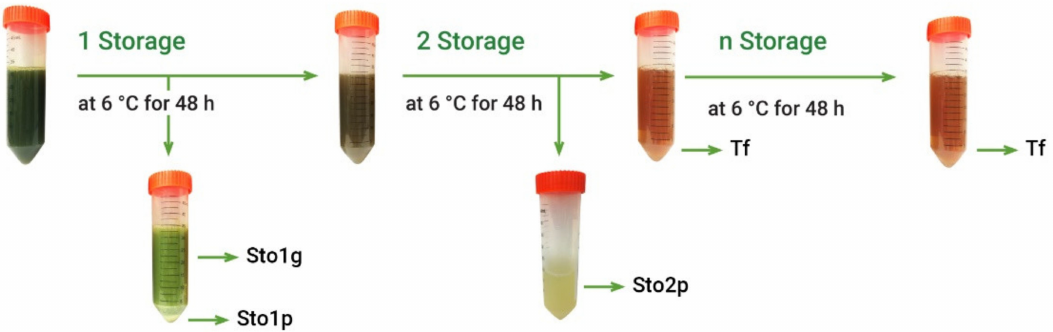
Figure 2. Fractionation scheme of hydroethanolic extract (EHs) of A. theiformis . Sto1g—green fraction (storage 1); Sto1p—precipitated fraction (storage 1); Sto2p—precipitated fraction (storage 2); Tf—transparent